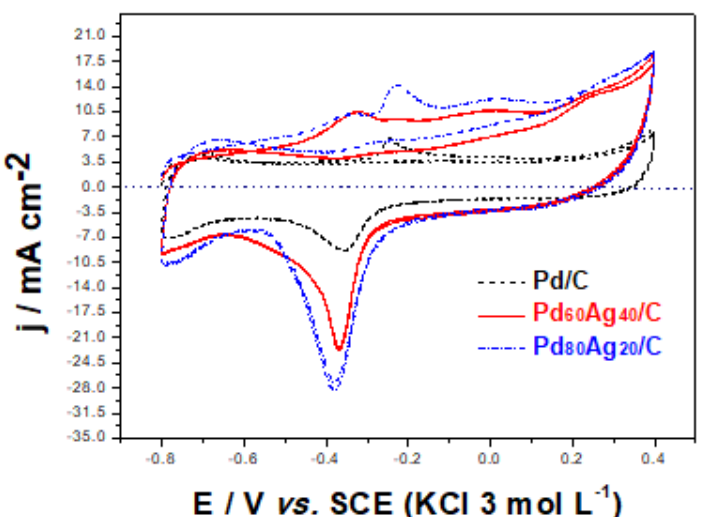
20 mV s − 1 Figure 6 . CO-stripping of the electrocatalysts 40% Pd-based/C in KOH 1.0 mol L −1 at scan rate of 20 mV s −1 .